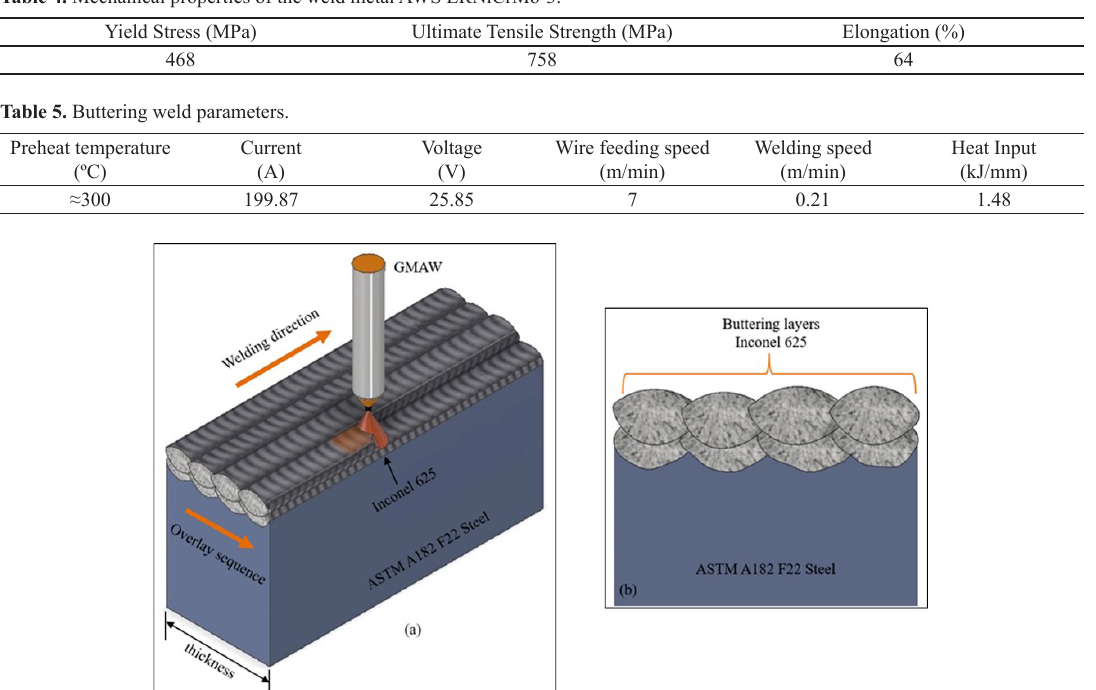
Table 4. Mechanical properties of the weld metal AWS ERNiCrMo-3.